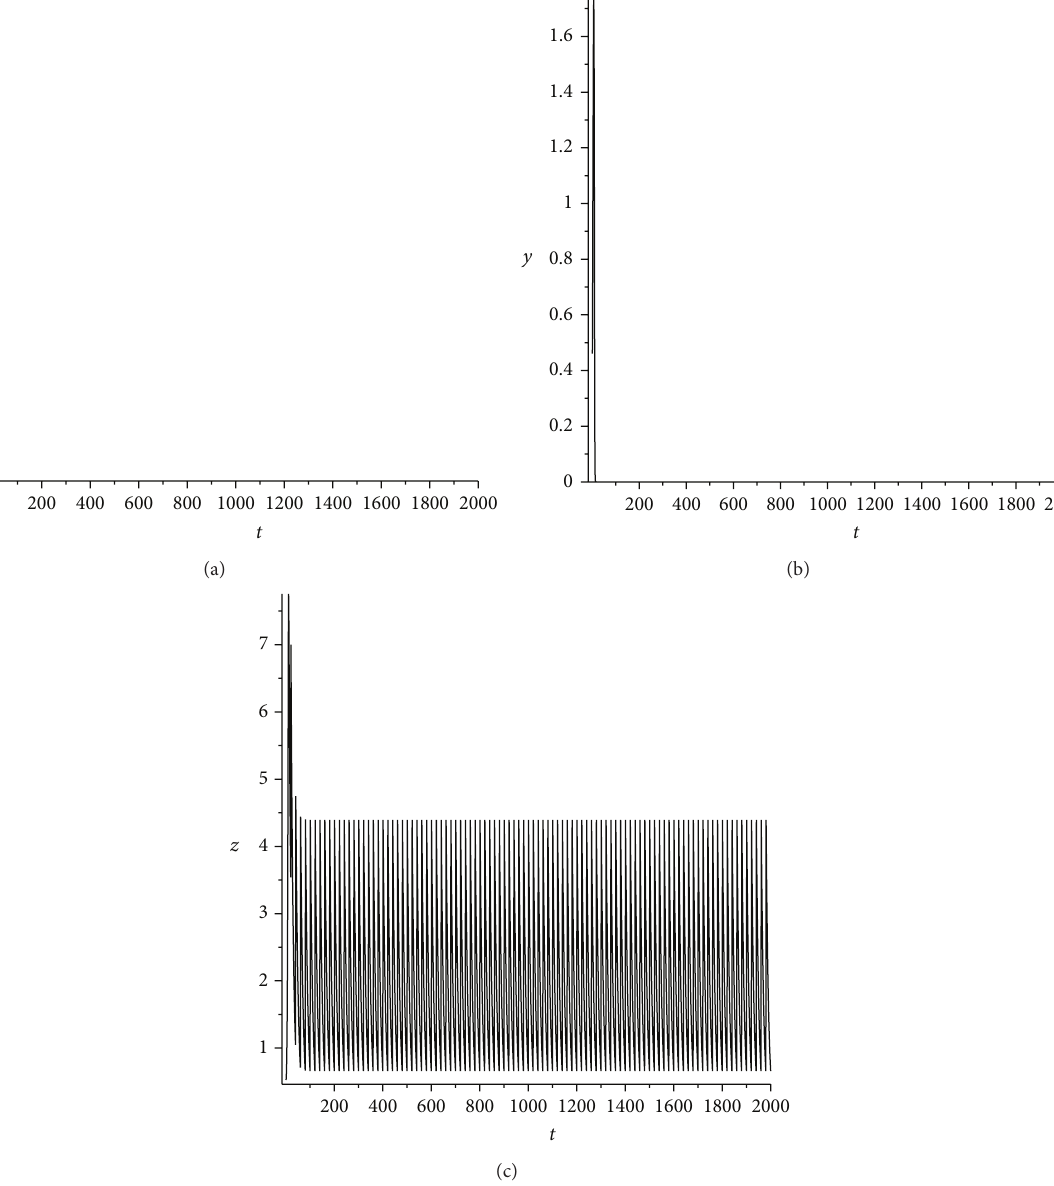
Figure 1: Time series of System (2) when 𝑢 = 0.8 and 𝑝 = 4.2